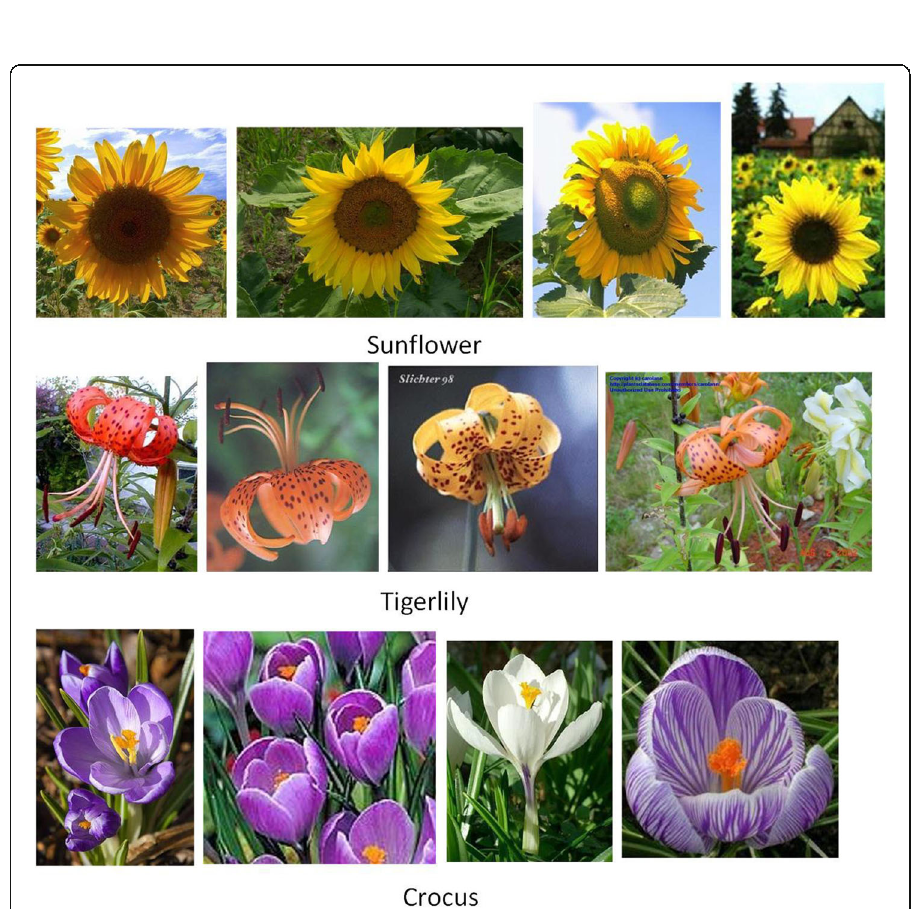
Fig. 14 Some examples of flower